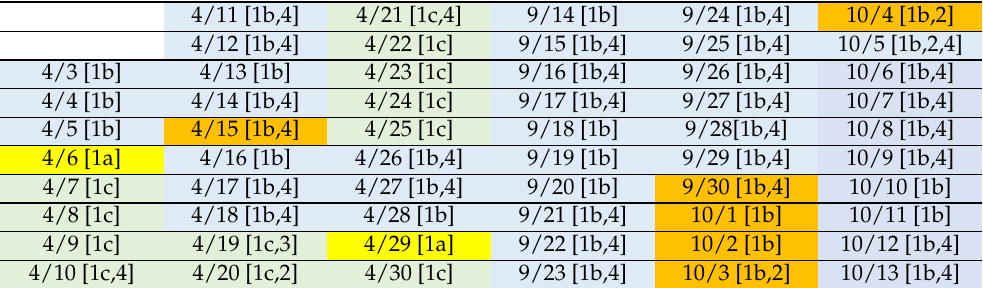
Table 2. Results of sea breeze type identification in case 2019s and 2019a. (Each cell represents a day with date inside, the text in square brackets show the rules that were met.)